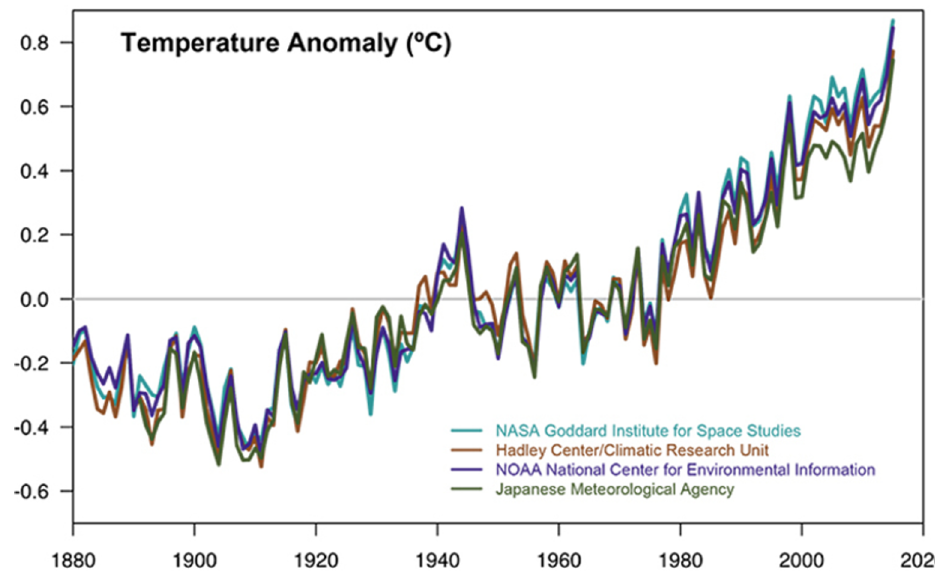
Fig 1. This graph aggregates temperature data from four institutions to show rapid warming in the past few decades, with the last decade the warmest on record. Data sources: NASA’s Goddard Institute for Space Studies, National Oceanic and Atmospheric Administration National Climatic Data Center, Met Office Hadley Centre/ Climatic Research Unit, and the Japanese Meteorological Agency. Graph courtesy NASA .